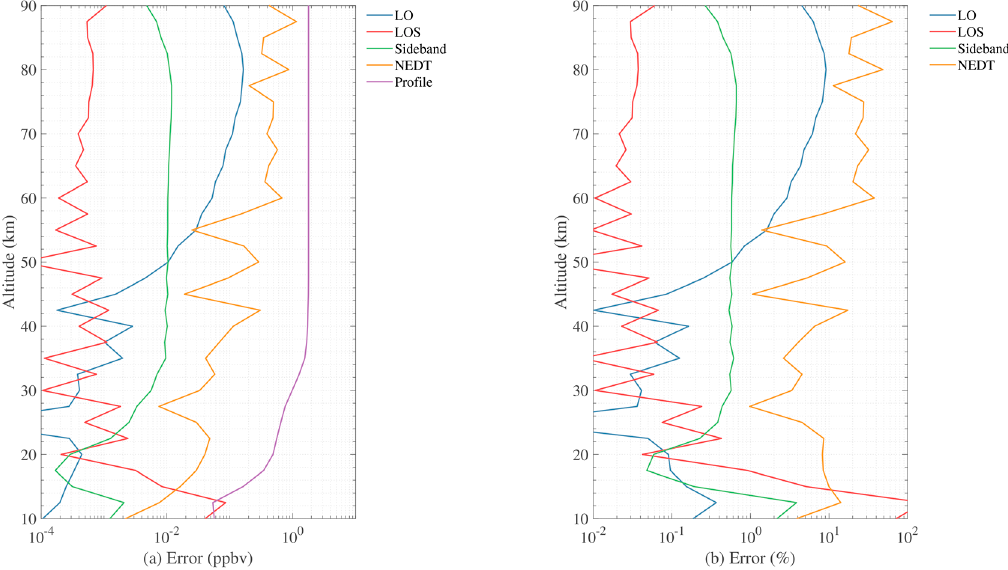
Figure 17. The HCl retrieval errors induced by different instrument uncertainty sources: ( a ) absolute and ( b ) relative retrieval errors. The uncertainties assumed are summarized in Table 3.